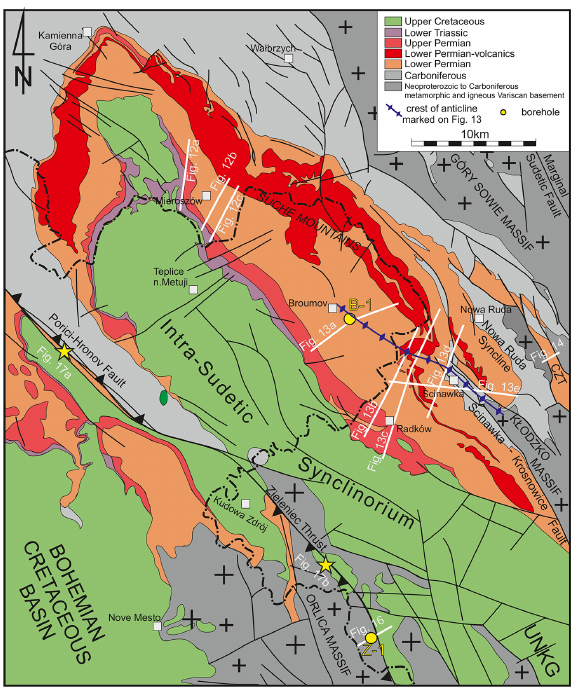
Figure 11. Geological map of the Intra-Sudetic Synclinorium (based on Grocholski and Augustyniak, 1971; Bossowski and Bałazi´nska, 1982; Bossowski and Ihnatowicz, 2006; Cymerman, 2010). Location of the interpreted seismic profiles and described localities is shown. CZT – Czerwie´nczyce Trough (reverse graben); UNKG – Upper Nysa - Králiky